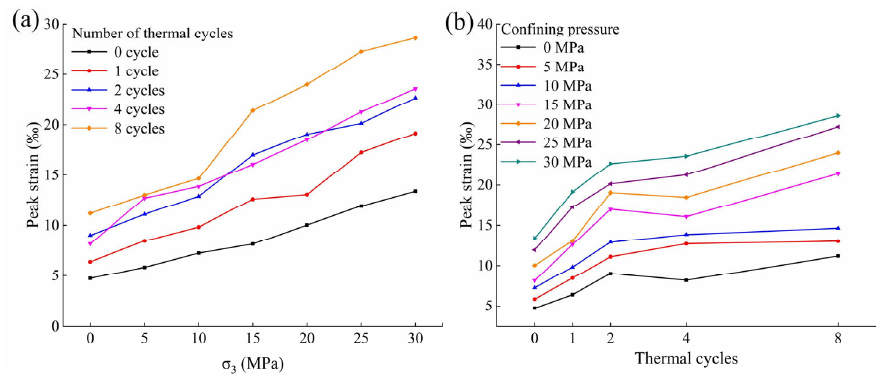
Figure 7. Relationship between peak strain of marble and the confining pressure and the number of thermal cycles. ( a ) Peak strain- σ 3 under different thermal cycles; ( b ) Peak strain-thermal cycles under different confining pressure.